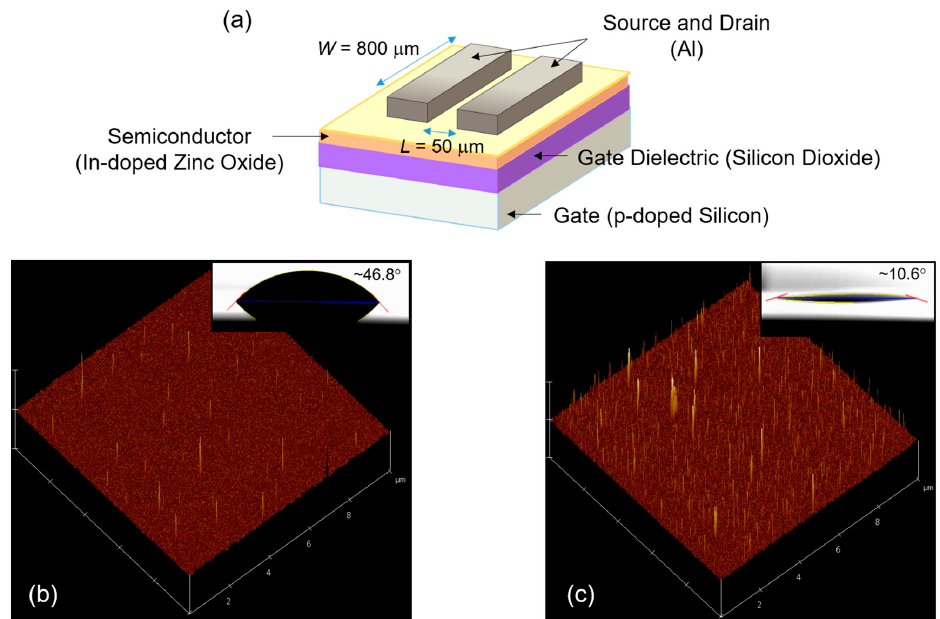
Figure 1. ( a ) Schematic representation of the fabricated In-doped ZnO TFT having the channel length (L) and width (W) of 50 m and 800 m, respectively. Atomic force microscope images (10 10 m) of the ( b ) pristine and ( c ) O 2 plasma-treated SiO 2 dielectric layers. The insets show the contact angles of both layers.